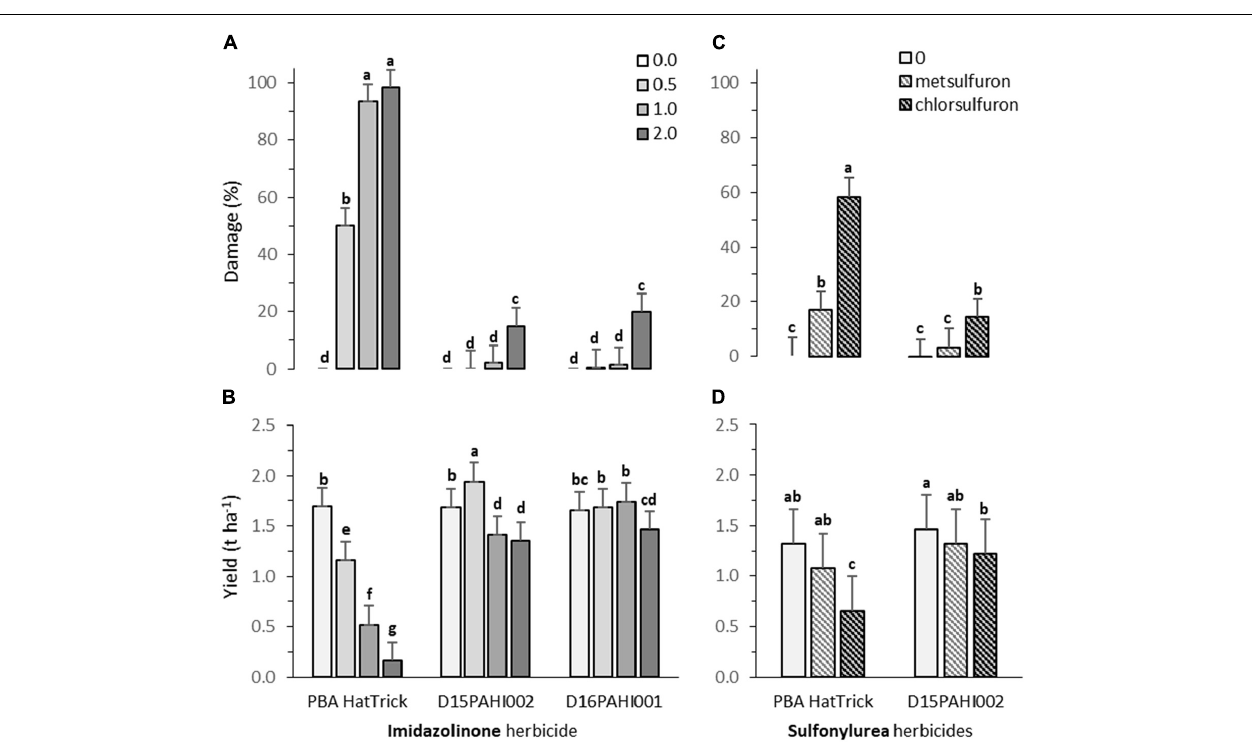
FIGURE 3 | Plant damage (%) and yield (t ha – 1 ) for cultivar PBA HatTrick and derivative mutants DH15PAHI002 and D16PAHI001 selected for tolerance to Group 2 imidazole herbicide following (A,B) post-emergent (5-node stage) applications of herbicides, at 0, 0.5, 1.0, and 2.0 times the recommended field use rate of 24.8